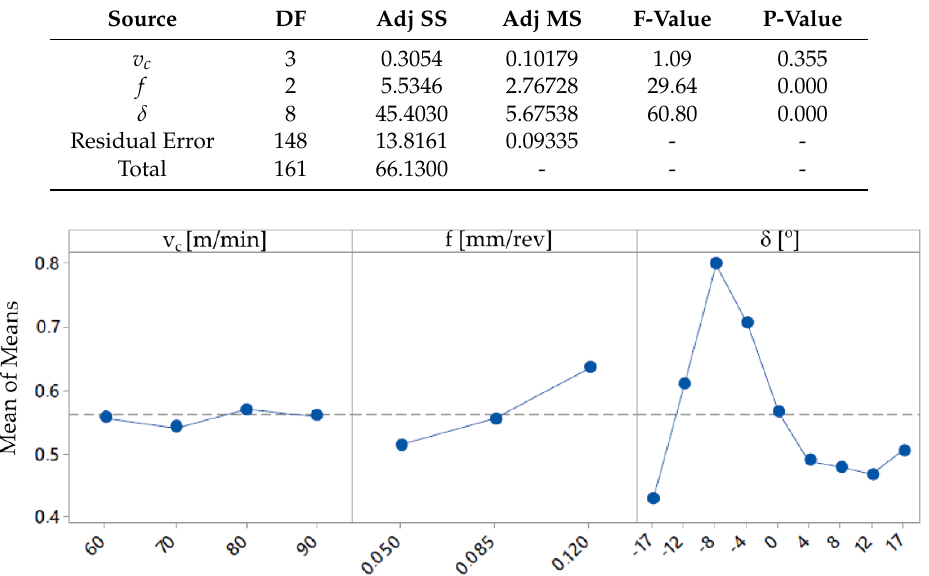
Table 5. Analysis of ANOVA variance for surface roughness parameter Rz.